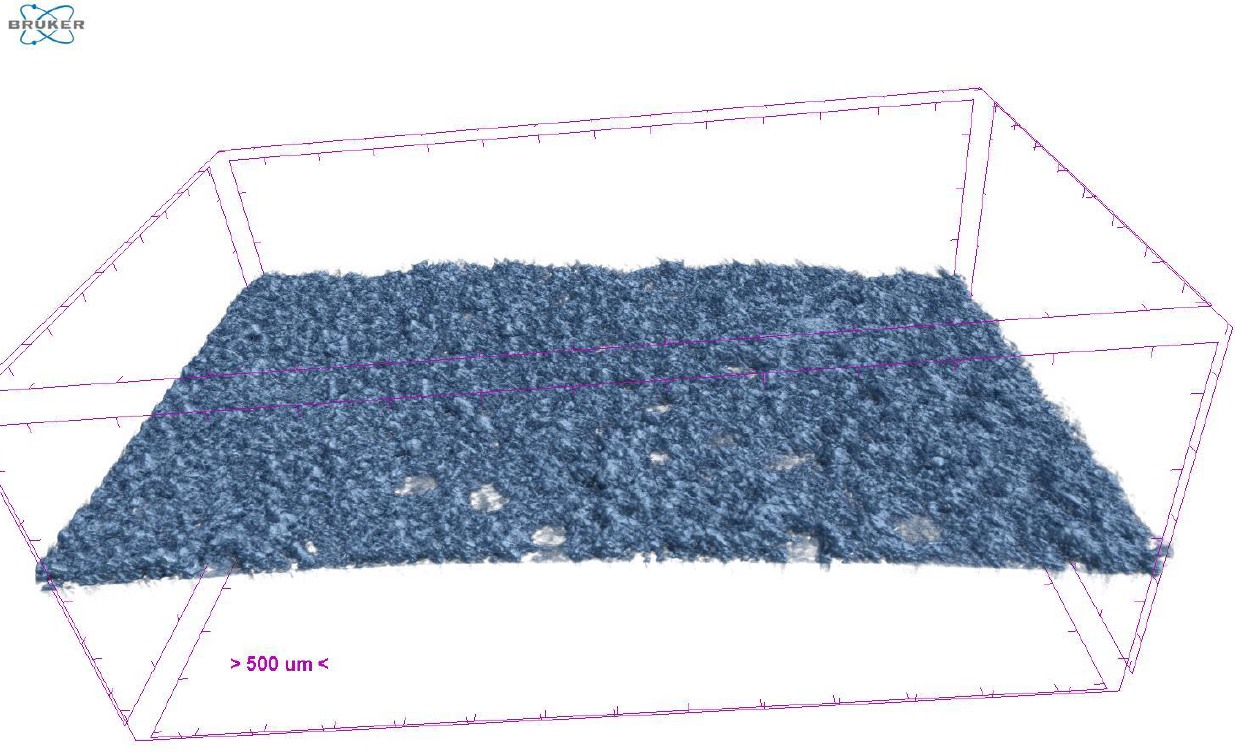
Figure 3. Micro-CT reconstruction of XF5